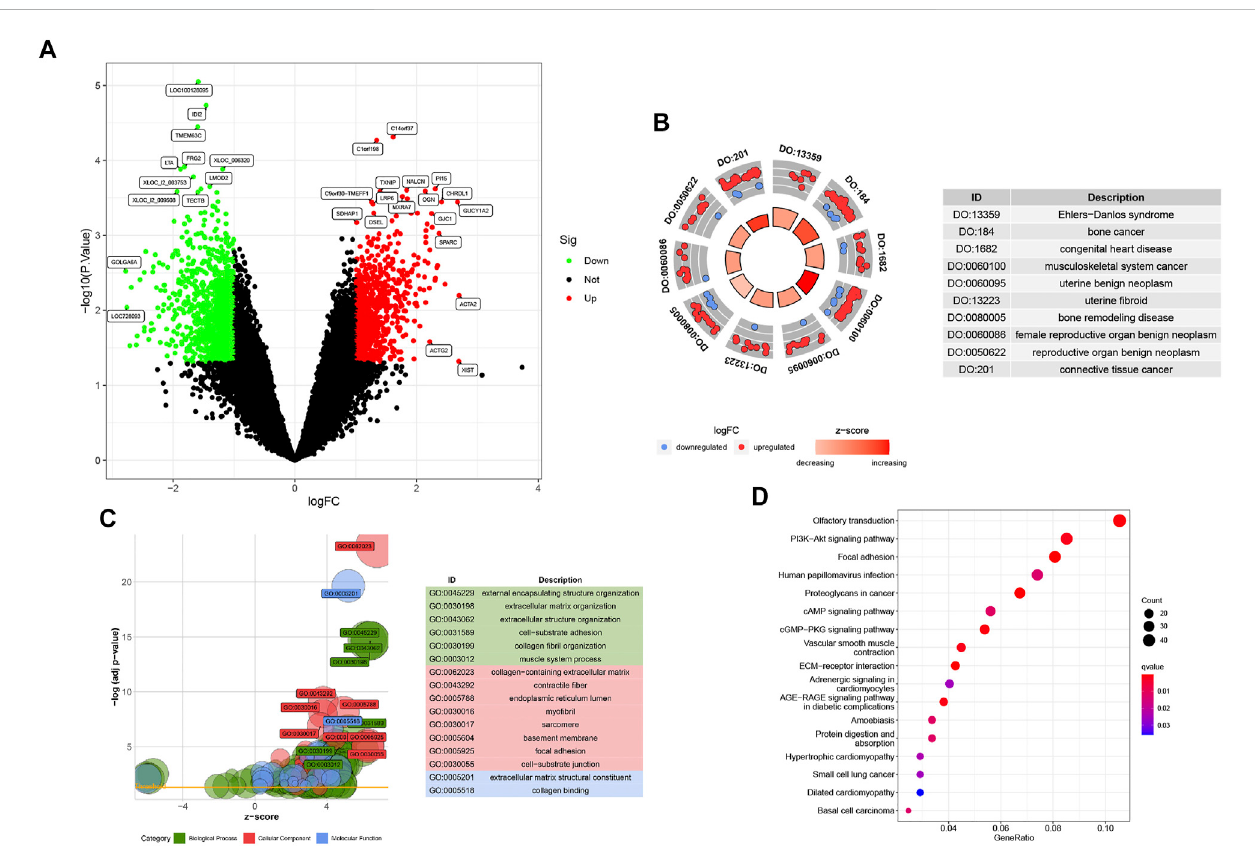
FIGURE 2 (A) Baseline p1 with 1905 DEGs, including 840 upregulated and 1065 downregulated genes. (B) DO analysis involving the top 10 related diseases. (C) All GO analyses for DEGs are divided into BP, CC, and MF parts. (D) KEGG bubble plot of Randall ’ s plaque